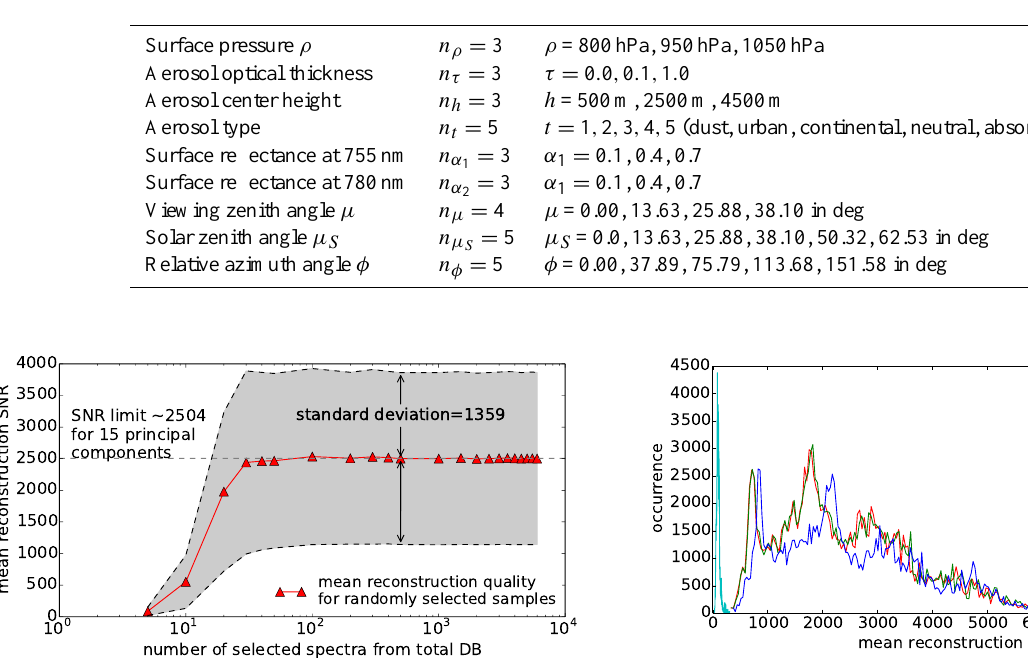
Table 1. State vector parameters of the discussed lookup table database. The state space contains physical parameters as well as the viewing geometry of a hypothetical instrument. The nadir viewing geometry is constrained to 0 ◦ –40 ◦ where the solar zenith angle and the relative viewing azimuth are less constrained. The aerosol optical models were implemented according to Levy et al. (2007). Here, a rather coarse resolution for all parameter states was chosen to simplify the presented analysis. The total number of 3 · 3 · 3 · 5 · 3 · 3 · 4 · 5 · 5 = 121 500 physical cases is considered. The spectral sampling is 0.005nm, and 4500 channels within the O 2 A band were simulated. Altogether this table represents 121 500 · 4500 ≈ 5 . 5 × 10 8 radiative transfer simulations.